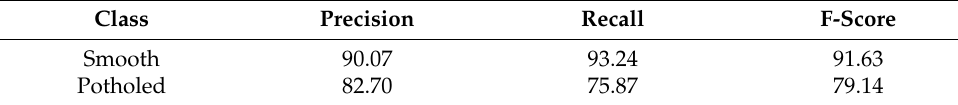
Table 8. Results per class for the SVM